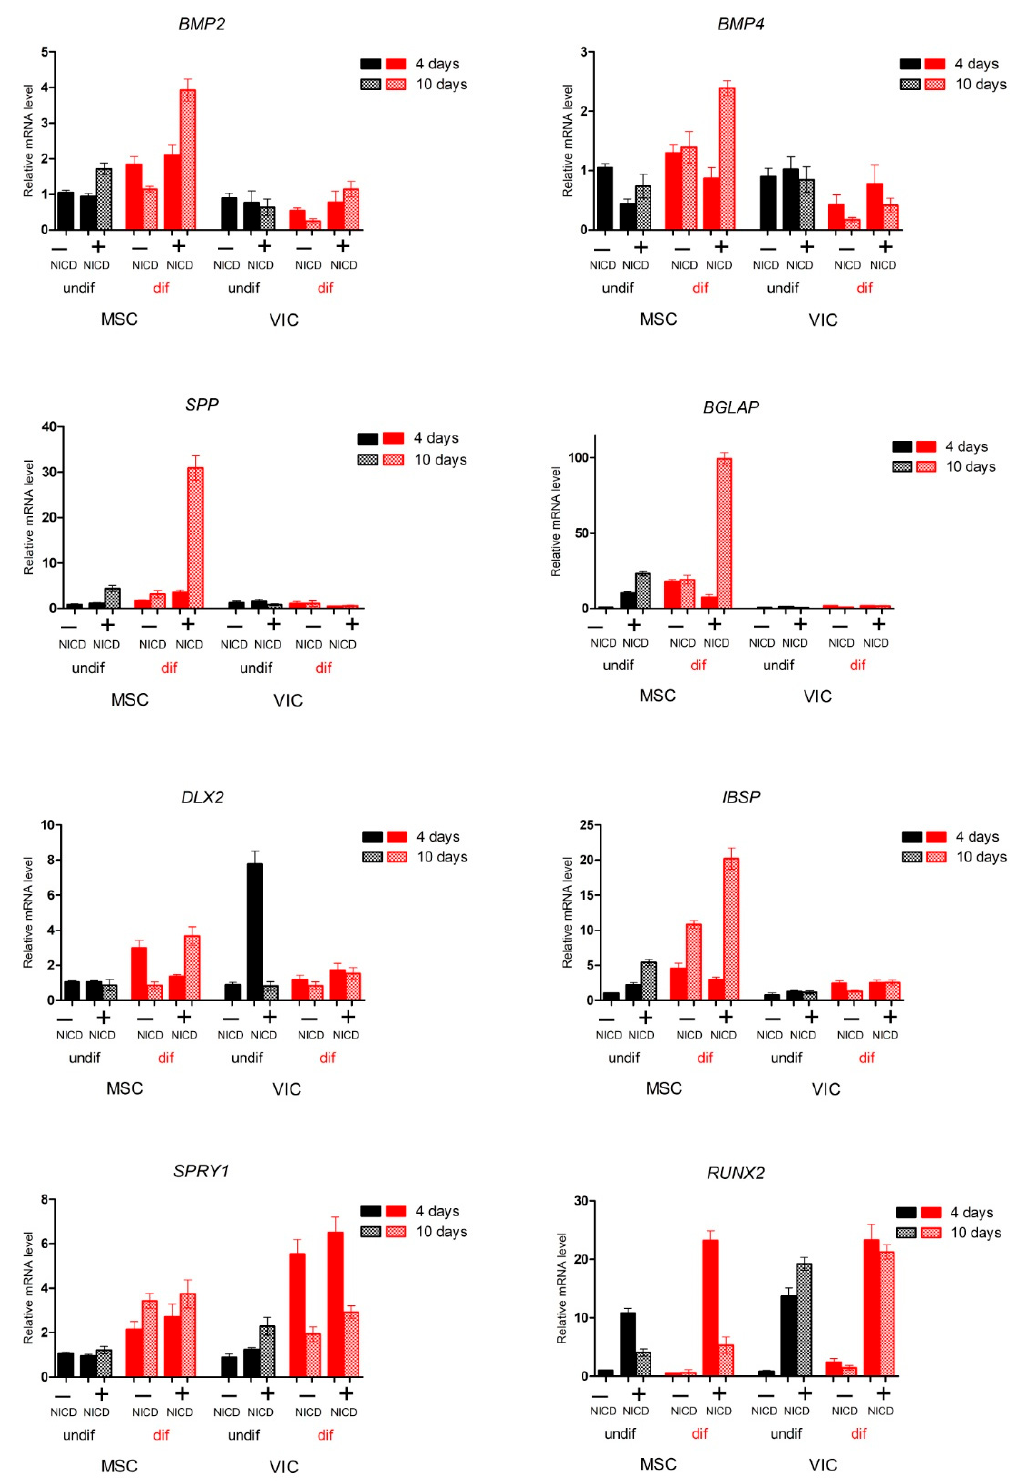
Figure 2. Mesenchymal stem cells (MSCs) of adipose tissue are different in their sensitivity to the Notch-dependent induction of osteogenic differentiation in comparison with aortic valve interstitial cells (VICs). The cells were transduced with the lentiviral Notch intracellular domain (NICD) and osteogenic differentiation was induced. The expression proosteogenic genes was analyzed by qPCR after either 4 or 10 days of differentiation.